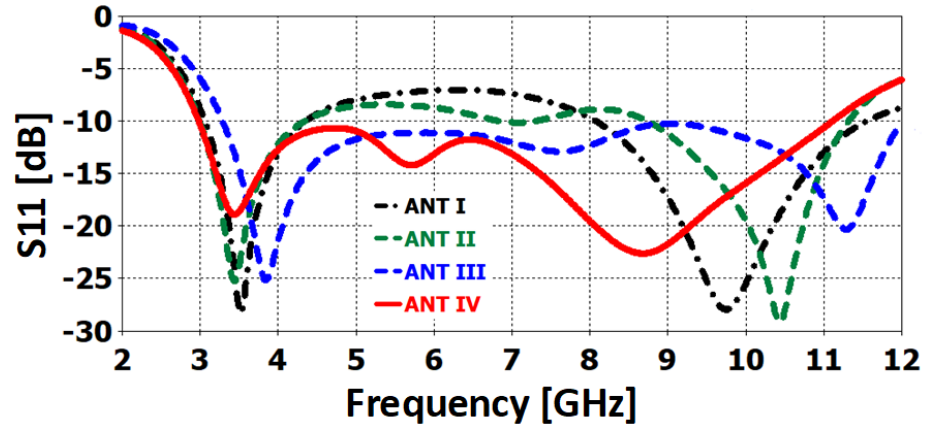
Figure 3. S 11 (dB) of the different design steps of the presented UWB antenna shown in Figure